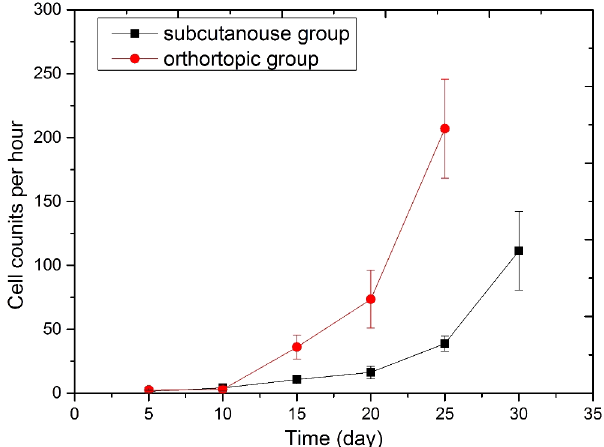
Fig. 6. The prostate tumor progression had di®erent pro¯les between subcutaneous tumor model and orthotopic tumor model. There was a di®erence in CTC counts between subcutaneous tumor model and orthotopic tumor model measured by IVFC.